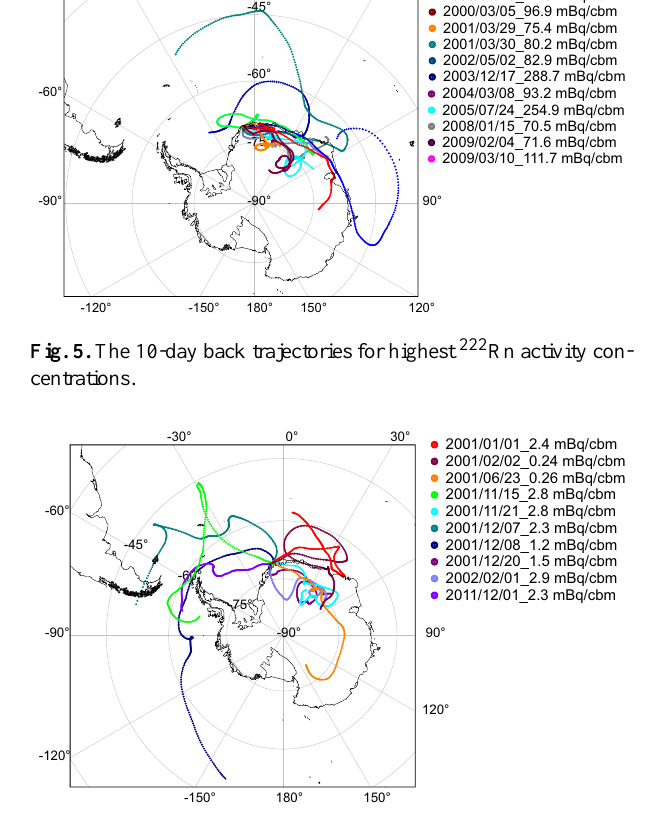
Fig. 6. The 10-day back trajectories for lowest 222 Rn activity con-